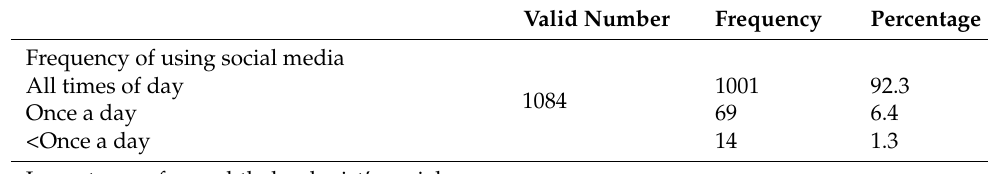
Table 2. Descriptive details of using social media sites among the participants.